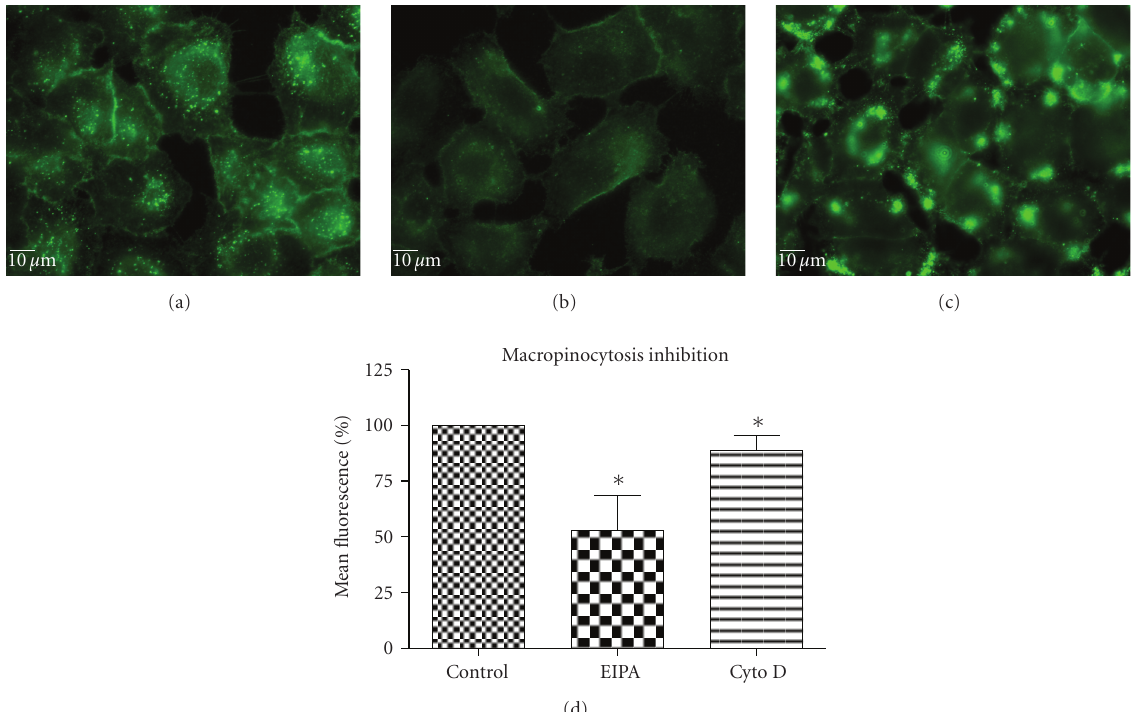
Figure 9: Macropinocytosis inhibition perturbed QD/SR9 internalization (150nM; 1:20; 1 hour). (a) Control cells. (b) Cells pretreated with EIPA for 30 min then incubated with QD/SR9 for an additional 1 hour. (c) Cells pretreated with Cyt D for 30 min then incubated with QD/SR9 for an additional 1 hour. Images are from a single plane of Z series. (d) Fluorescence intensity. Values are mean ± SD from three independent experiments ( ∗ P (cid:5) s < . 01 versus